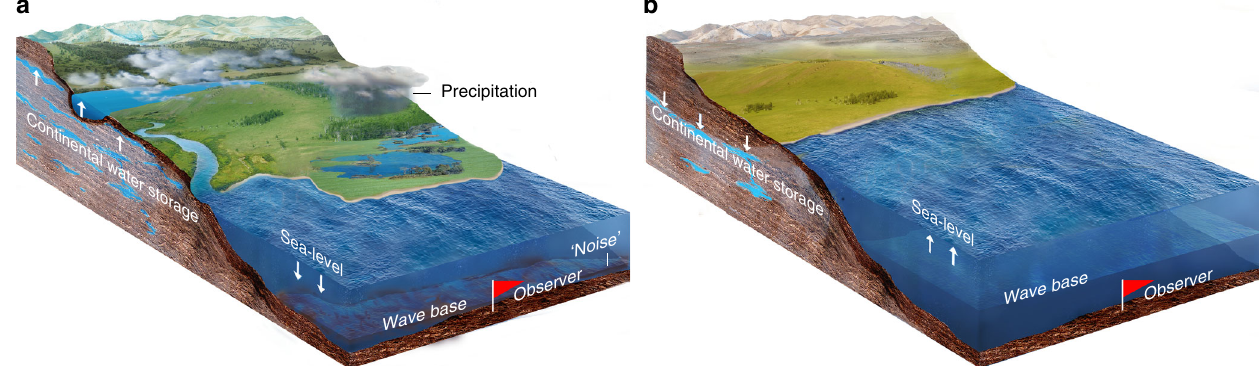
Fig. 7 Water exchange between continental water storage and the ocean forced by astronomically forced climate change leads to major sea-level variations. a More moisture transferred to the continent leads to recharging of groundwater and lakes, and a fl ourishing terrestrial ecosystem. This results in a lowering of sea-level and wave base and more environmental noise (e.g., increased sediment mixing) at the location of observer (red fl ag). b Less moisture transferred to the continent leads to depleted groundwater and lakes, and a rise in sea-level and wave base with less environmental noise at the location of the observer. Illustrations © Hewei